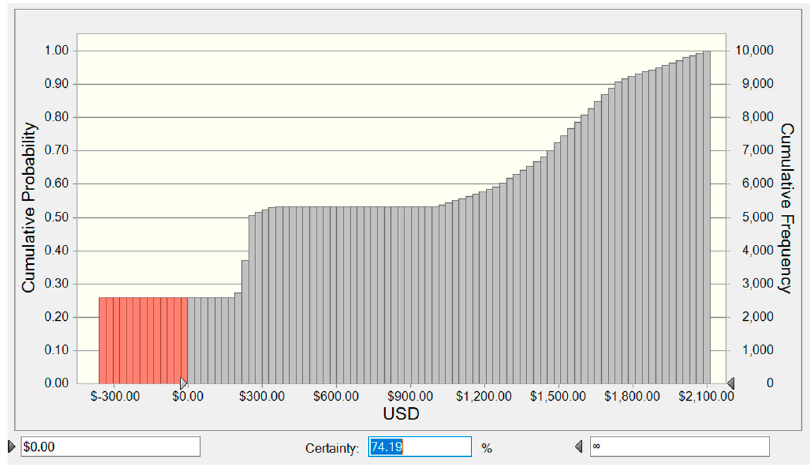
Figure 5. Stochastic results of NPV in the NE region.